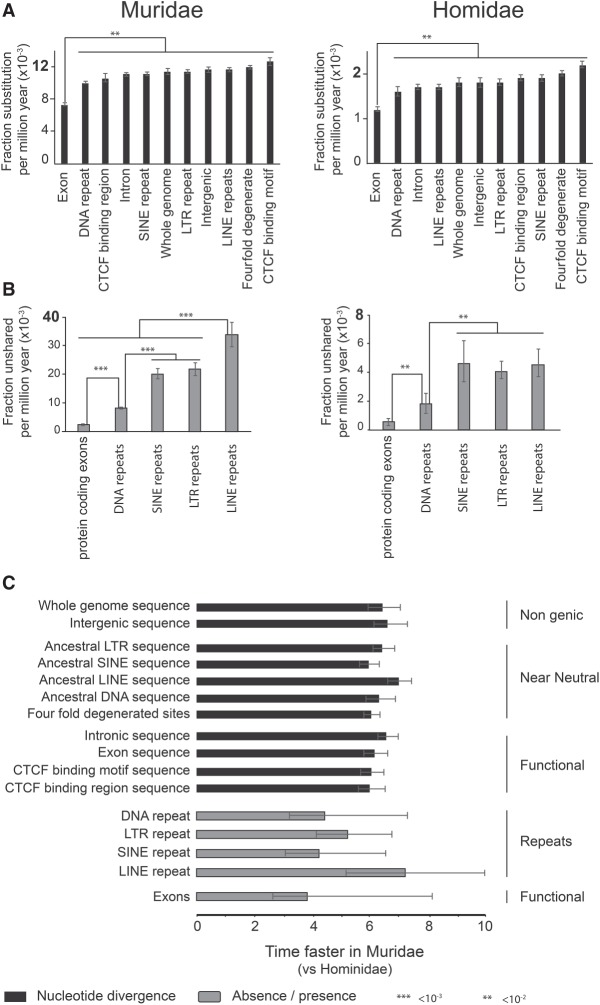
Acceleration of mutational rates in the Muridae lineage. (A) The evolutionary rate of nucleotide variation calculated for specific genomic regions. The error bar represents the standard error within the 95% confidence interval. (B) The rate of segmental turnover calculated for specific genomic regions. The error bar represents the standard error within the 95% confidence interval (Supplemental Methods SM3.2). (C) The bar chart shows the ratios of evolutionary rates between Muridae and Hominidae. Mouse versus human ratios were calculated for rates of nucleotide divergence (black bars) and the turnover rates (gray bars) for specific genomic regions (Supplemental Methods SM3.2).